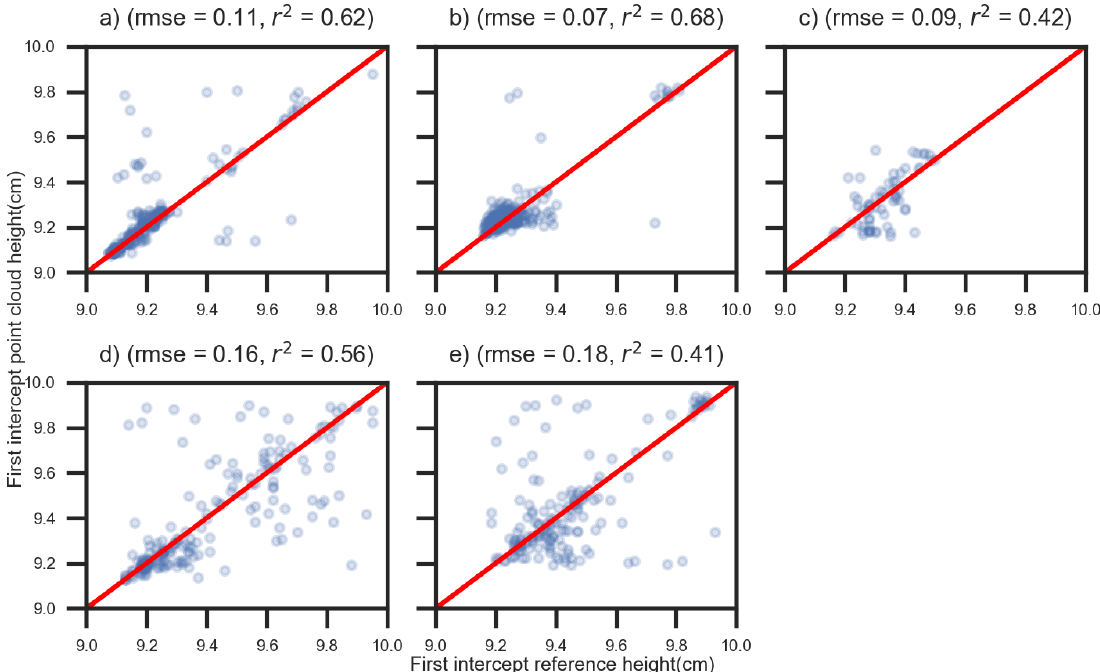
Figure 7. TLS estimate of first intercept height derived from point clouds in comparison to direct measurements at: ( a ) High Camp; ( b ) Ridgeway; ( c ) Royal park; ( d ) Silvan1; and ( e ) Silvan2. Both the x and y axes show height relative to the origin of the reference